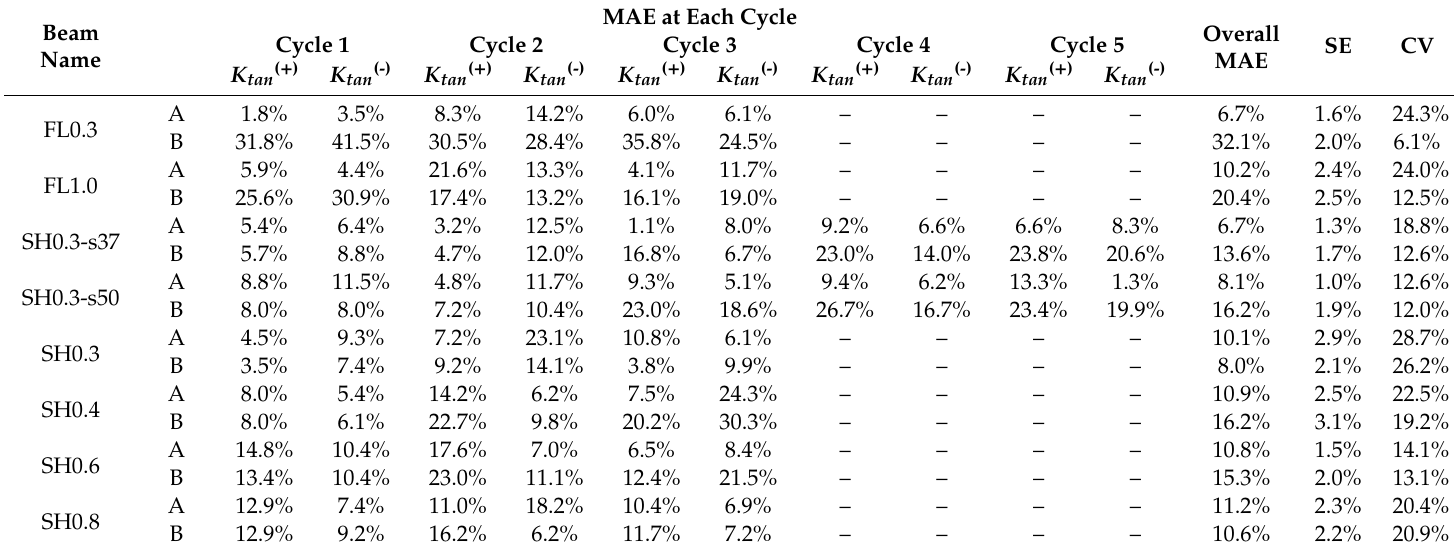
Table 6. Error calculation in the prediction of tangent sti ff ness, K tan